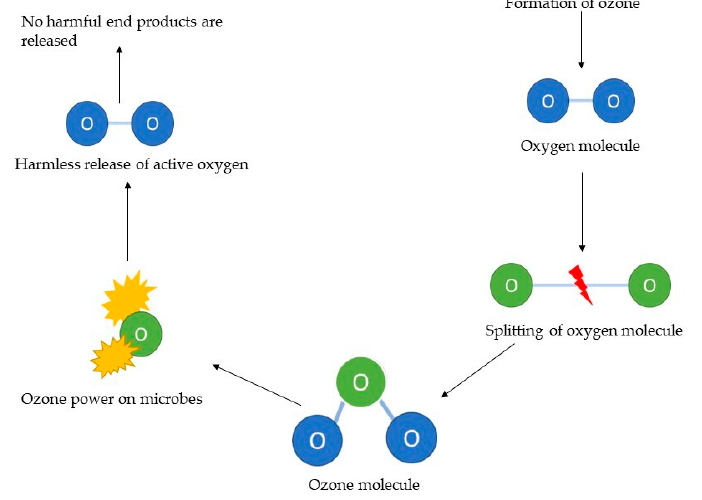
Figure 1. Ozone residues.